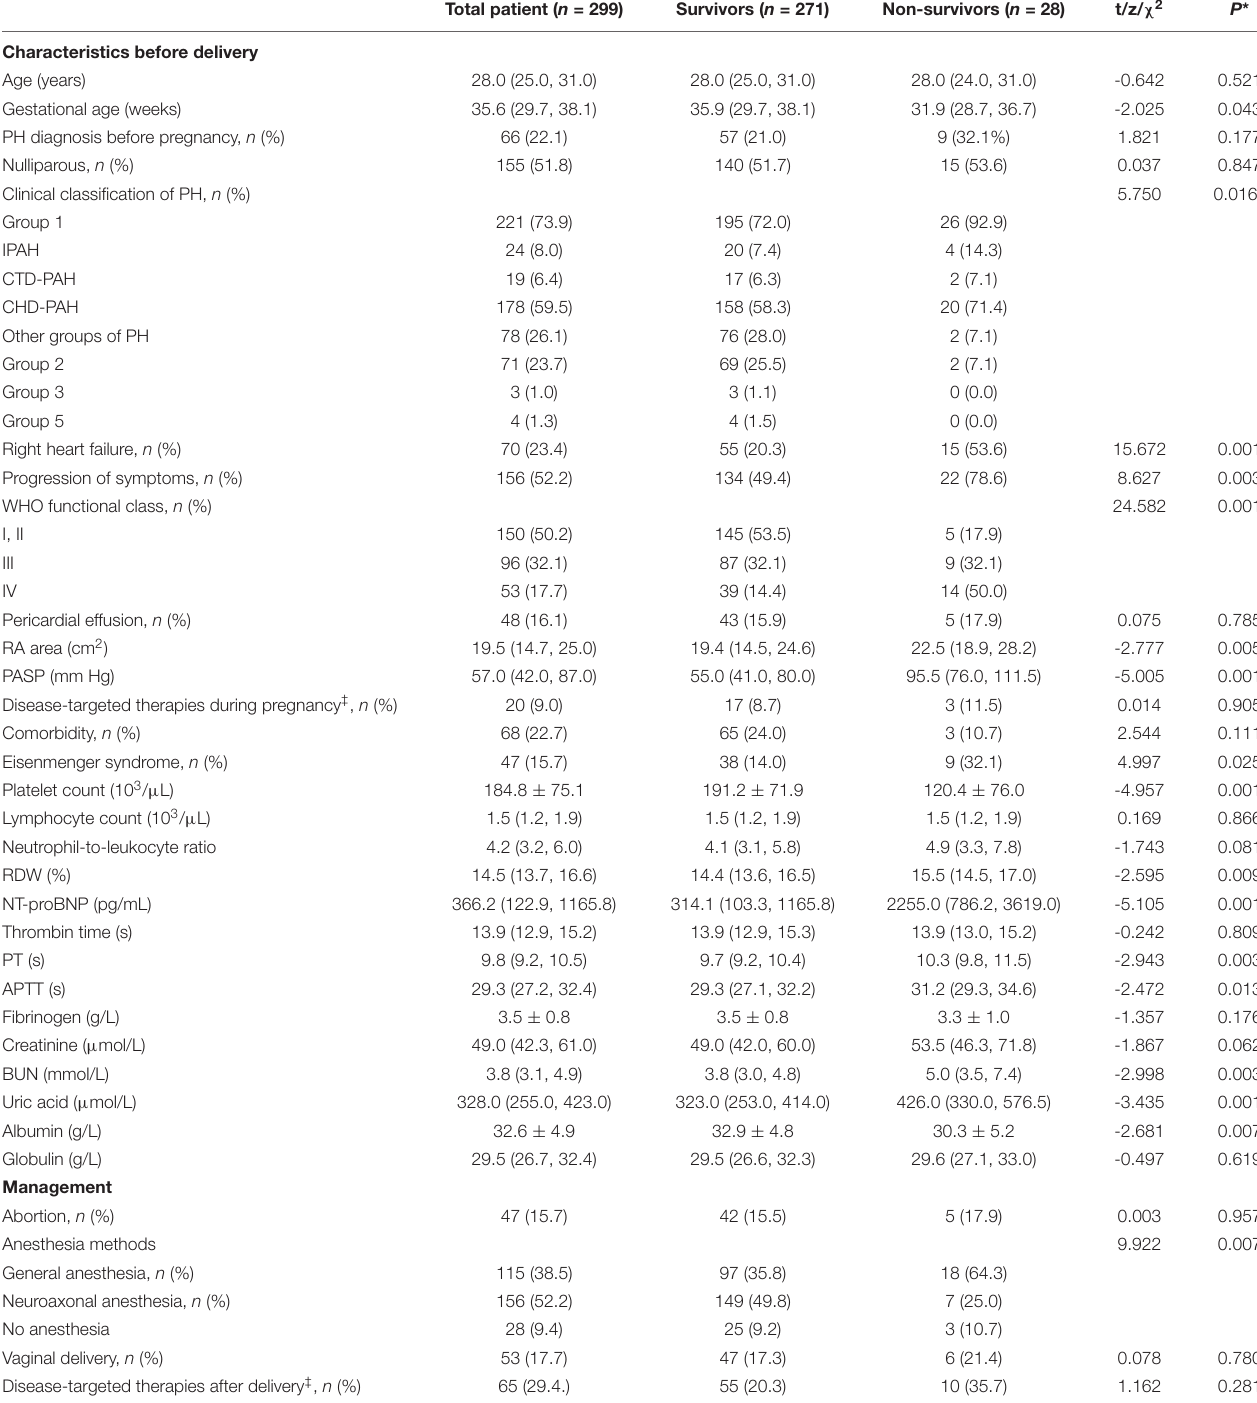
TABLE 1 | Comparison of demographic and clinical characteristics between the survivor and non-survivor groups. Total patient ( n = 299) Survivors ( n = 271) Non-survivors ( n = 28) t/z/ χ